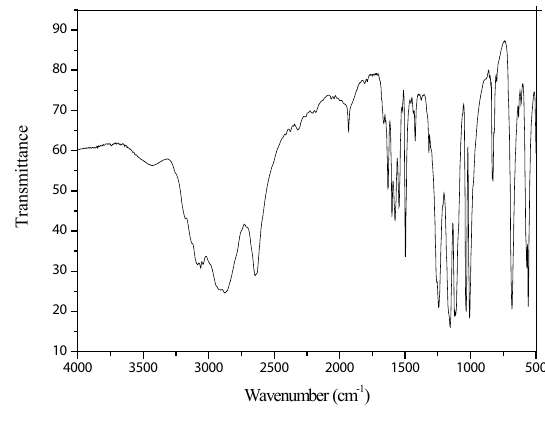
Figure 6: IR spectrum of 1